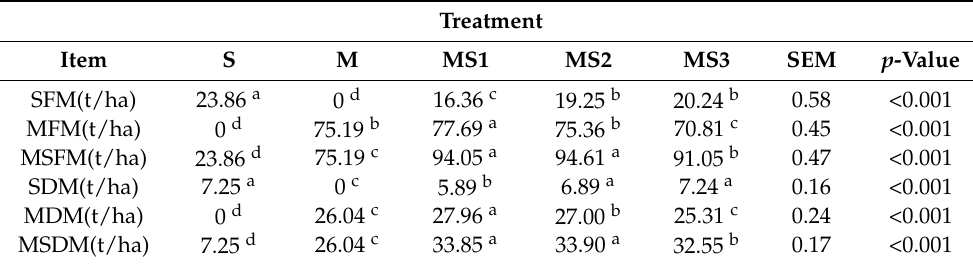
Table 1. The fresh and dry matter yields of maize and soybean using different cultivation models.